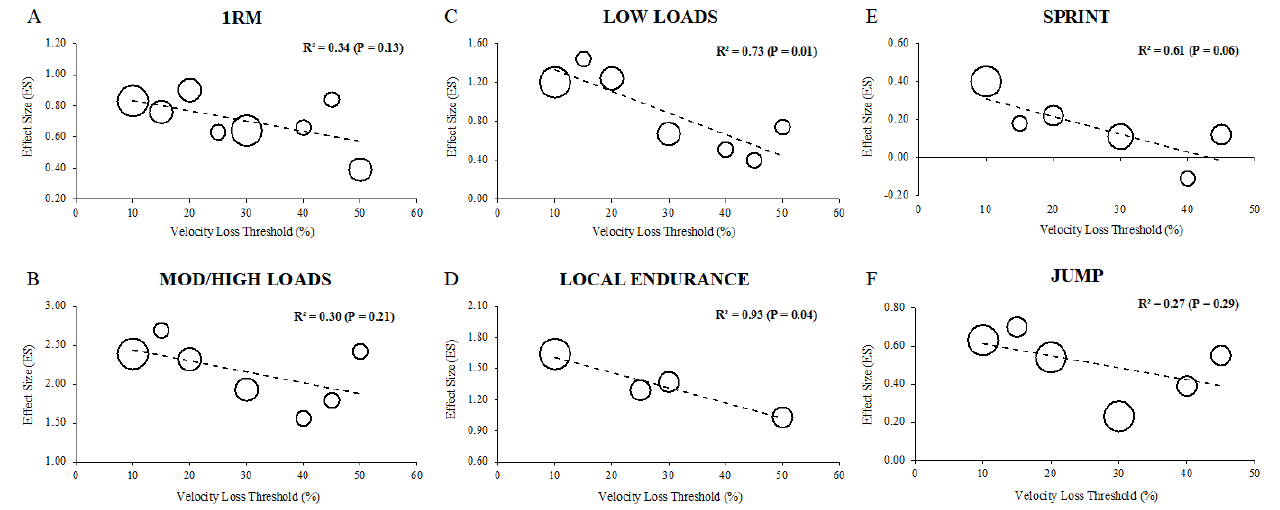
Figure 8. Bubble plots showing the relationship between individual VL thresholds and their respective effect size (ES) in each outcome. The size (area) of the bubbles represents the number of experimental groups ( k ) included in each VL threshold. A minimum of two groups ( k ≥ 2) training the same individual VL threshold was required to include it in the relationship analysis.